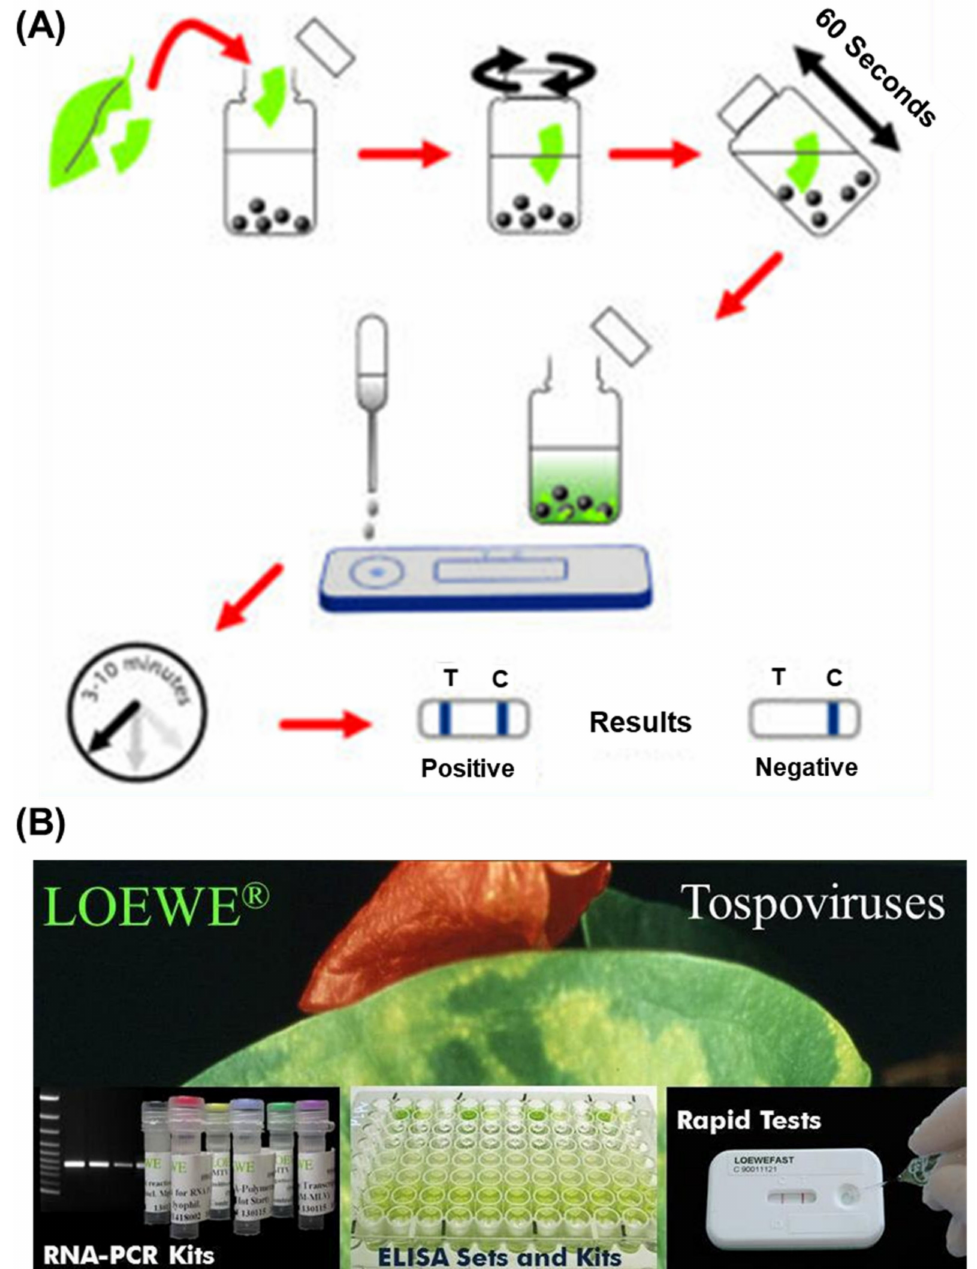
Figure 5. Commercially available rapid diagnostic kit for plant diseases: ( A ) method from pocket diagnostic and ( B ) Loewe RNA-PCR kit for virus. Adopted from www.loewe.com